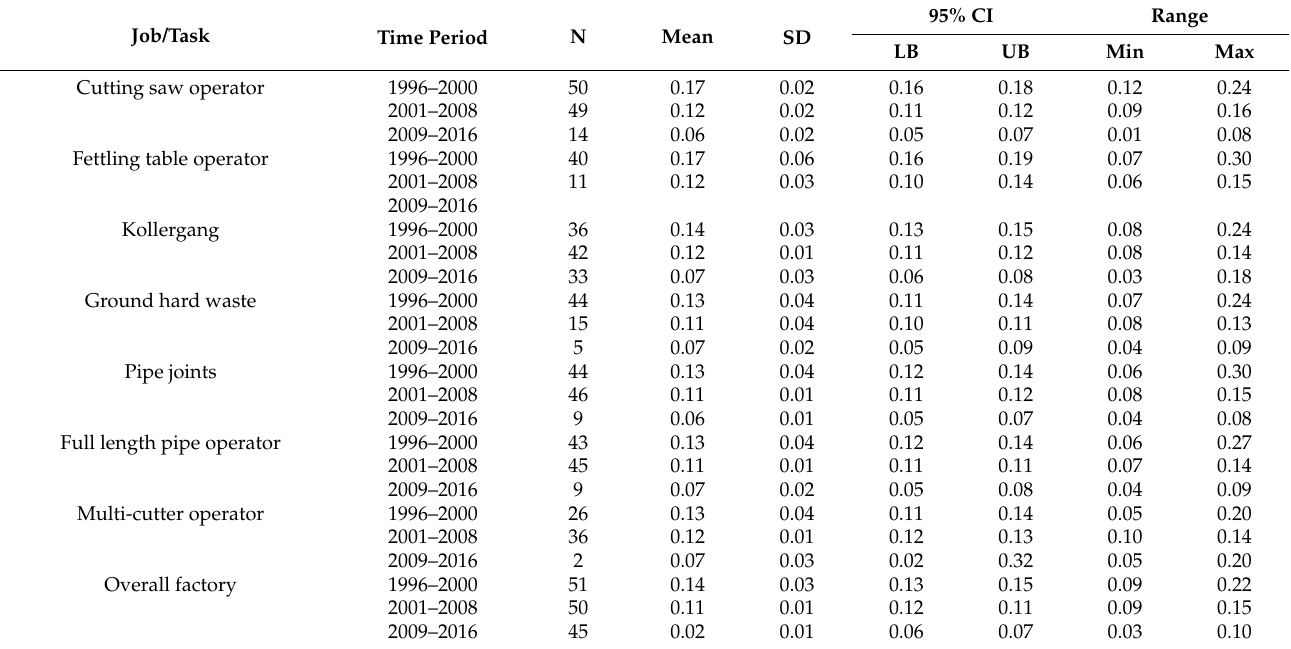
Table 5. Mean personal exposure chrysotile asbestos fibre concentrations (f/mL) by period between 1996 and 2016: Bulawayo